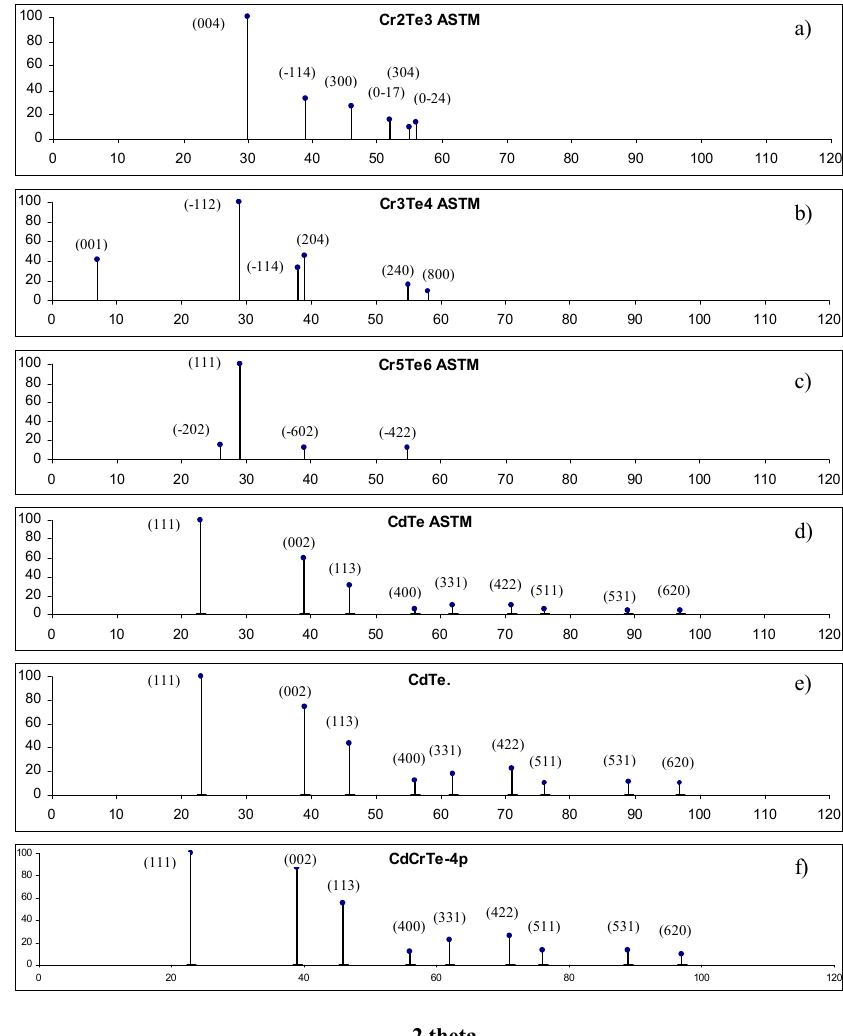
Figure 10. XRD spectra of CrTe, CdTe, ( a – d )—according to the ASTM tables, and CdTe, CdCrTe ( e , f )—experimental results.